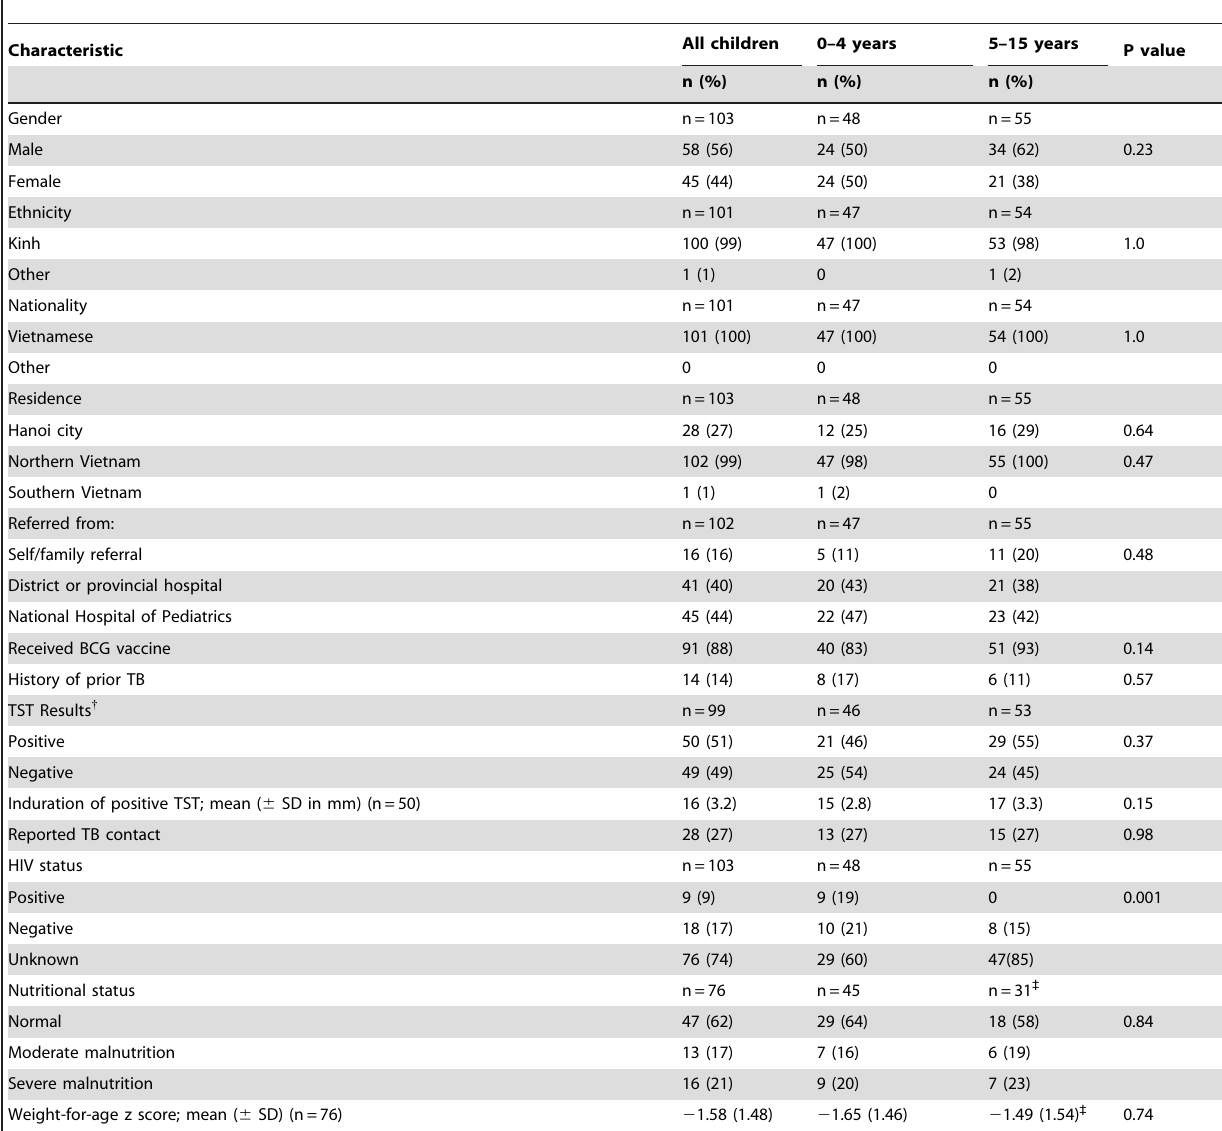
Table 1. Demographics, History, and Clinical Characteristics of Participants According to Age (n= 103*).